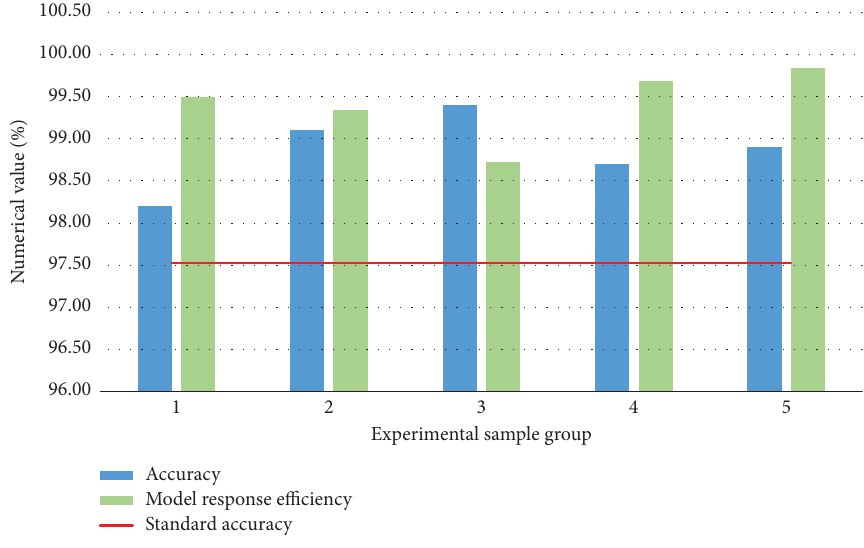
Figure 11: Results of the model running